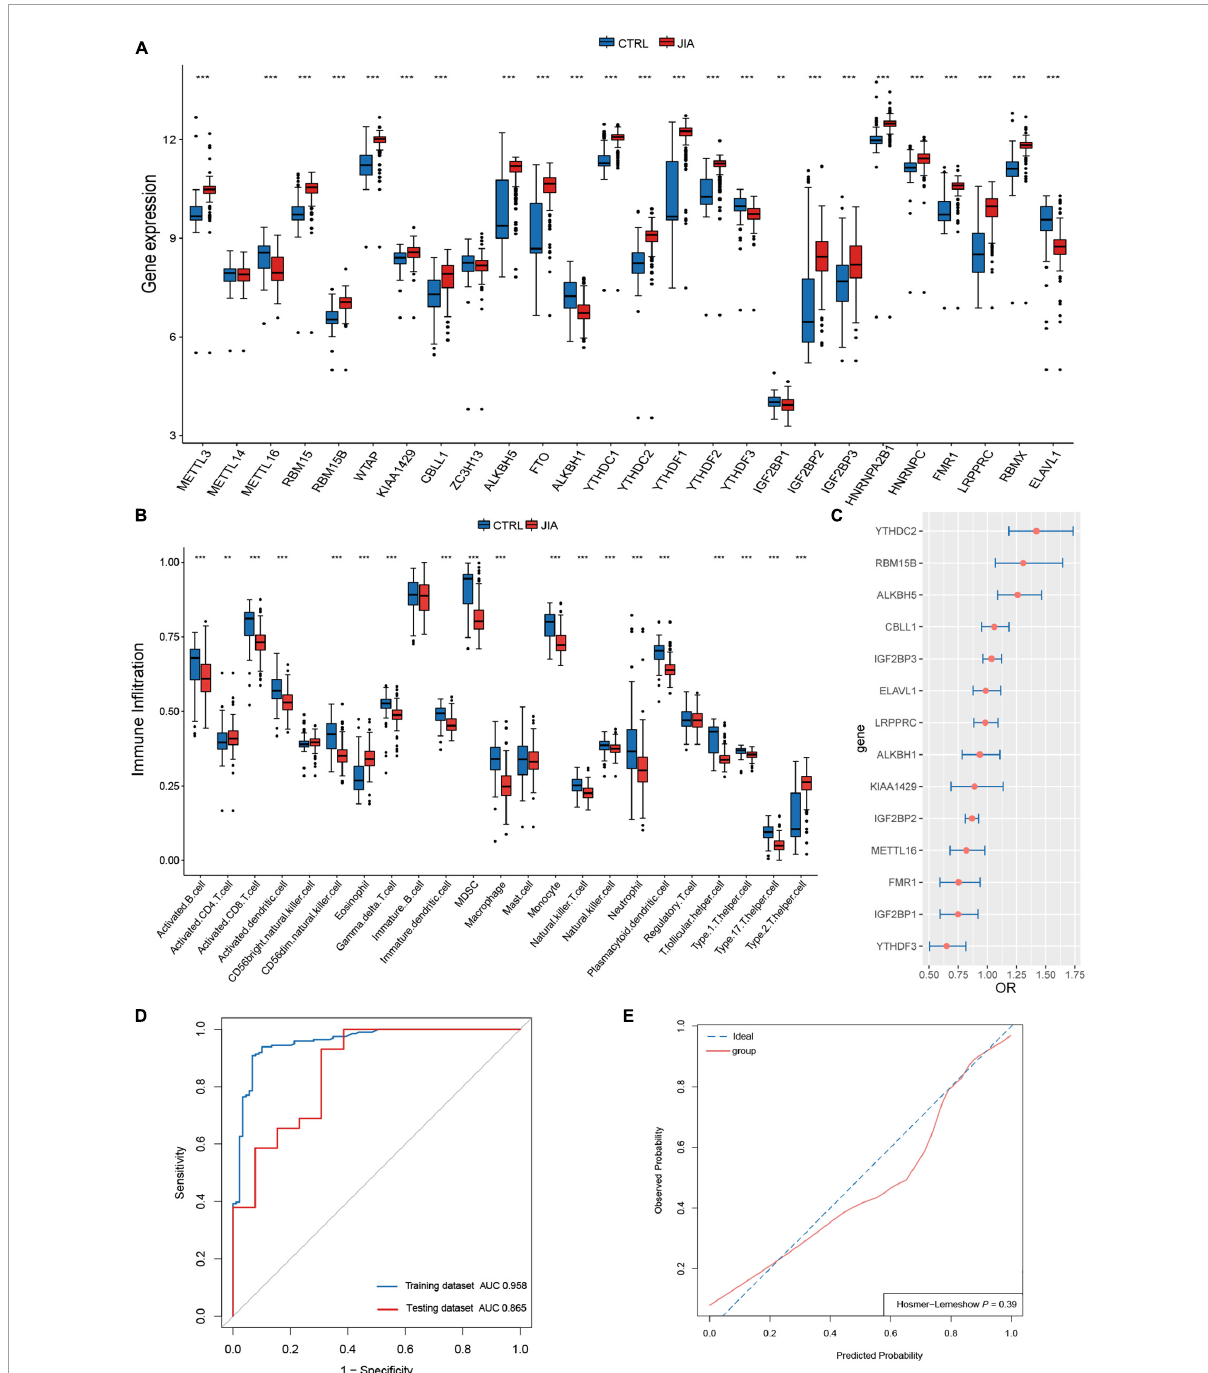
FIGURE2 A diagnostic model was constructed with m 6 A regulators for juvenile idiopathic arthritis (JIA). (A) Comparison of the expression of 26 m 6 A regulators in JIA and normal control samples. (B) The discrepancies in the abundance of each infiltrating immunocyte between JIA and healthy samples. (C) Relative risks of 14 diagnostic m 6 A regulators for JIA were calculated. (D) The developed diagnostic model for JIA was evaluated by the ROC curve and AUC value. (E) Hosmer–Lemeshow (H–L) test was used to evaluate the fit of the developed model.